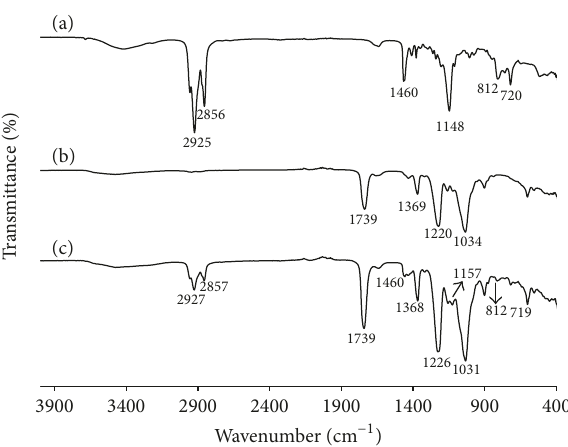
Figure 2: Infrared spectrum for (a) Cyanex 923, (b) cellulose acetate microcapsules, and (c) cellulose acetate microcapsules with Cyanex 923 at 1mol L −1